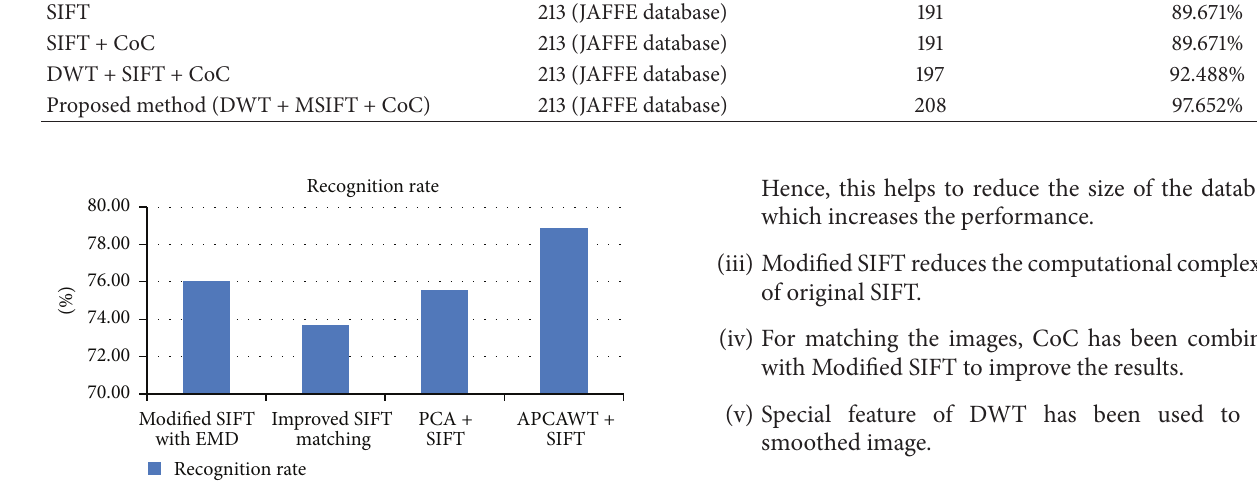
Figure 7: Image recognition rate of existing Modified/Improved SIFT techniques with JAFFE database.